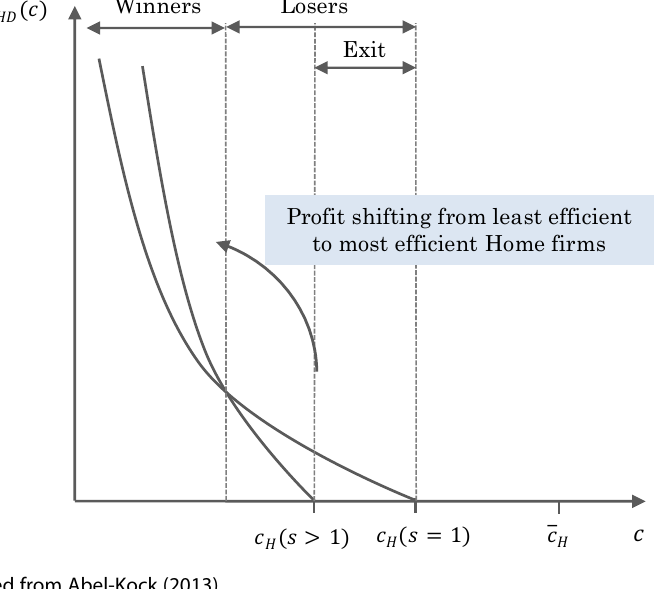
Figure 7. Introduction of a standard ( s > 1) on the profits of Home